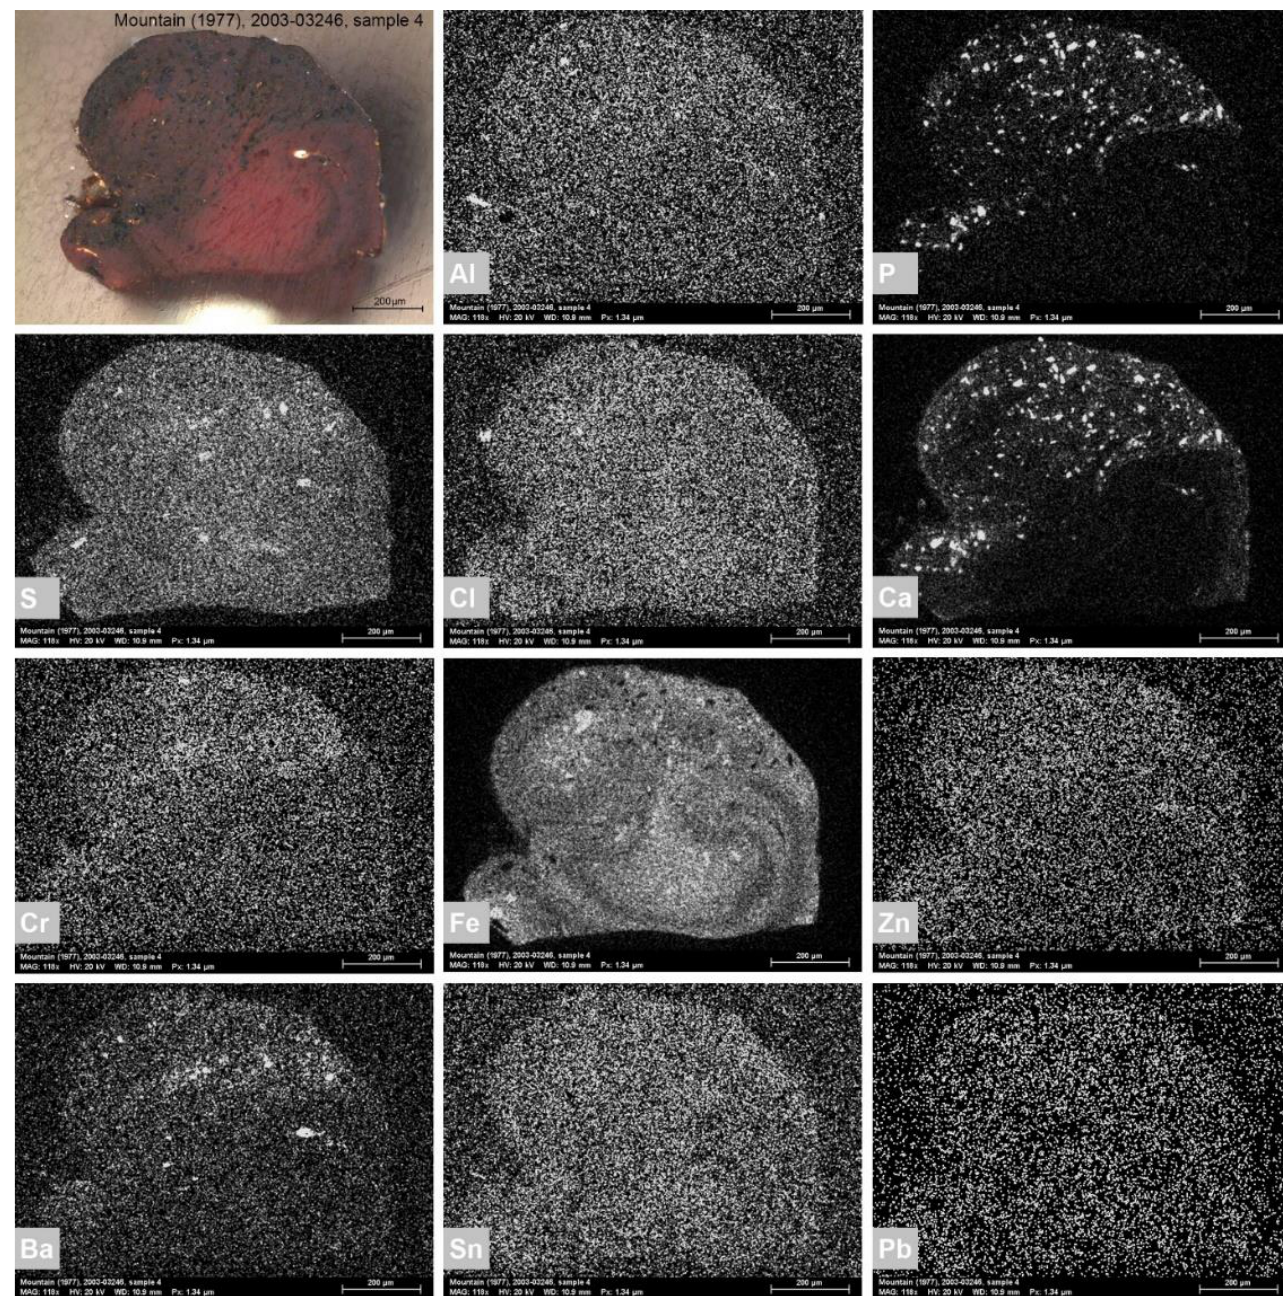
Figure 10. Optical microscopy image of the cross-section of sample 4 at 100 × magnification, extracted from Mountain , 1977, photographed in VIS ( top-left ), followed by SEM-EDS elemental distribution maps. The greyscale corresponds to the intensity of the signal of each element: white equals high intensity, and black means low intensity. A high intensity of the Fe signal suggests the use of red iron-containing earth. The concomitant presence of Ca and P signals highlights the use of bone black, whereas the co-location of the Al, Cl and Sn elements suggests the presence of organic red on Sn- or Al-based substrate. The concomitant presence of Cr, Zn, Ba and Pb may indicate the use of Cr-containing yellow(s).